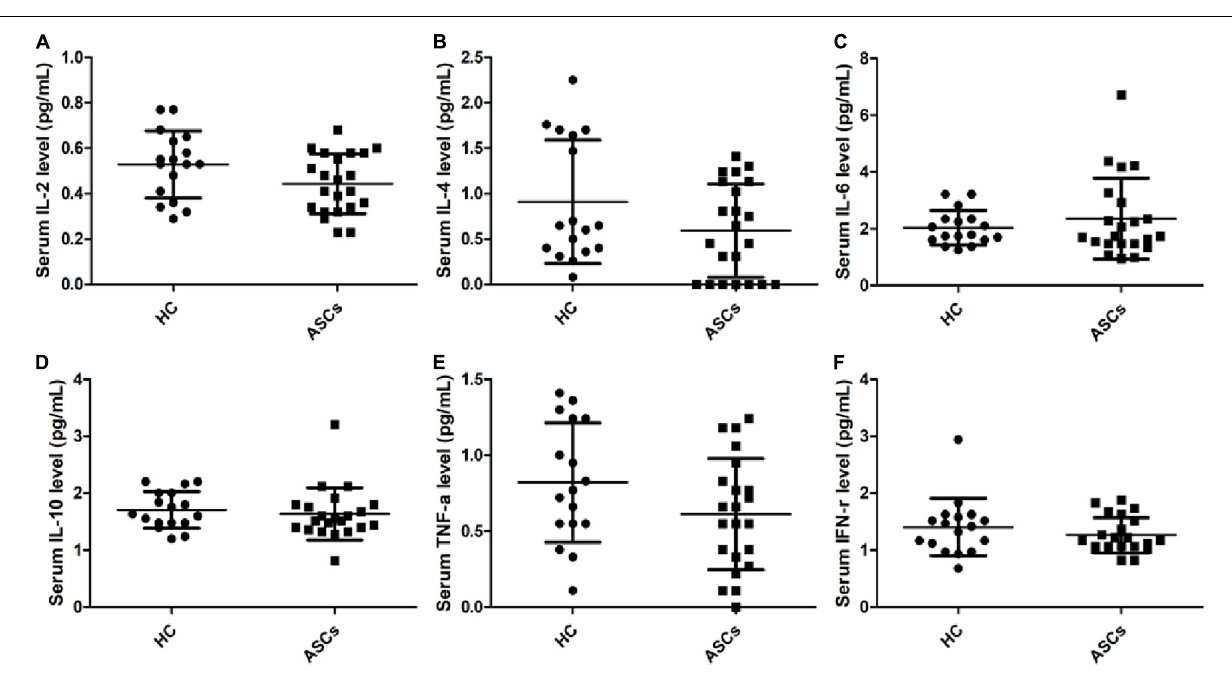
cells, and LAG-3 + CD4 + T cells, but not CTLA-4 + CD4 + T cells in chronic ASCs with HBeAg-negative in comparison with HC. The number and status of the patients possibly affected